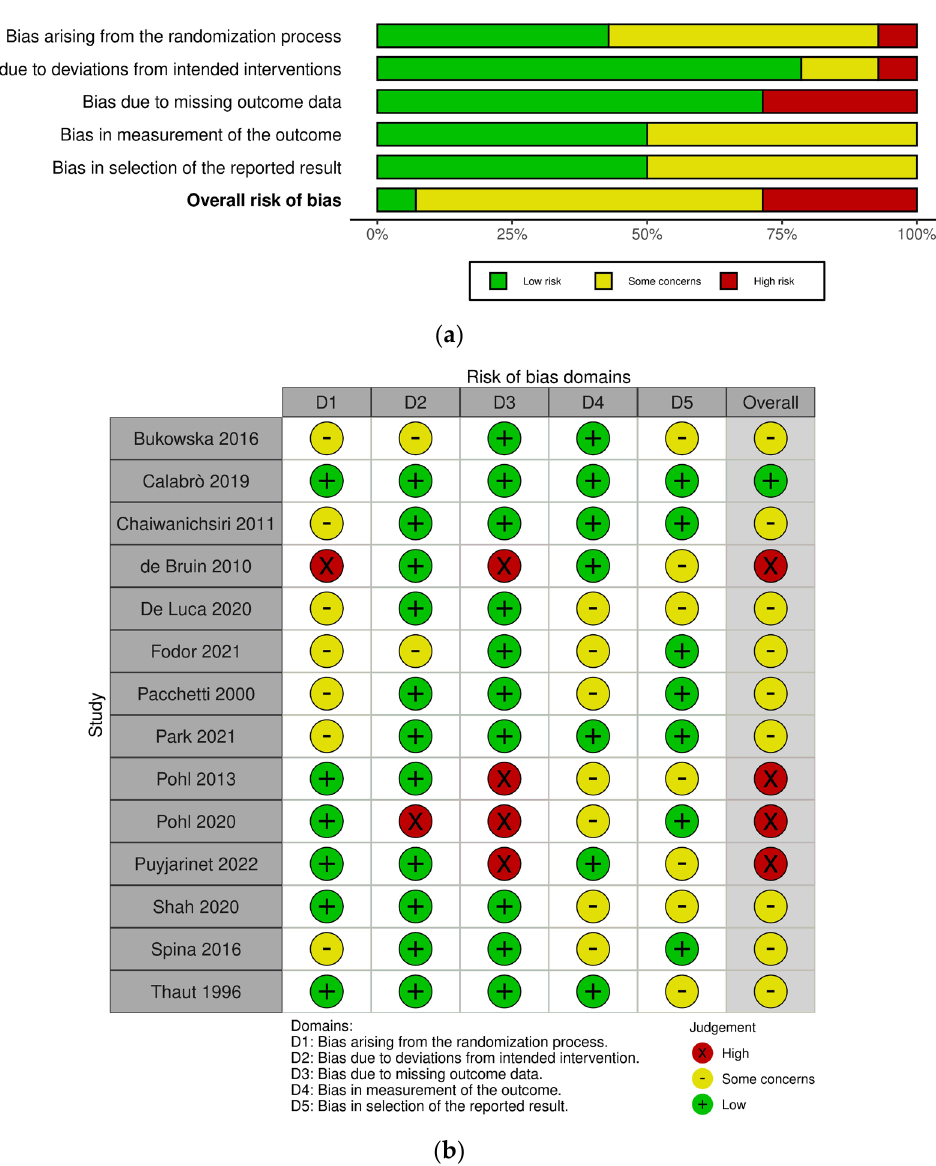
Figure 2. Risk-of-bias graphs for the randomized controlled trial (RCT) studies. ( a ) Risk of bias as a percentage and ( b ) risk-of-bias summary [16,19,26,27,30,36,38,39,54–59].